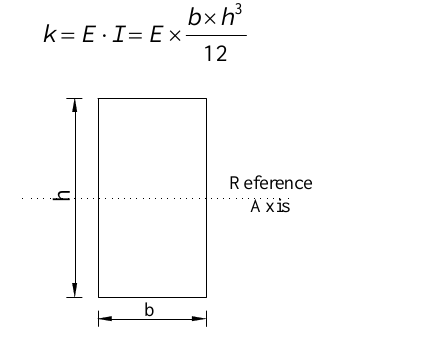
Fig. 1. Schematic diagram for rectangular section